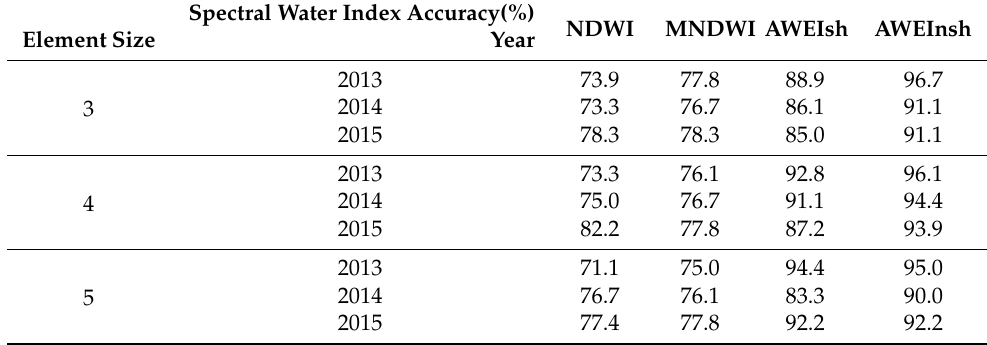
Figure 3. Characteristics of the water body of Beigang River extracted using differently sized structural elements. Table 5. Overall accuracy of the Beigang River area based on the different sizes of structural